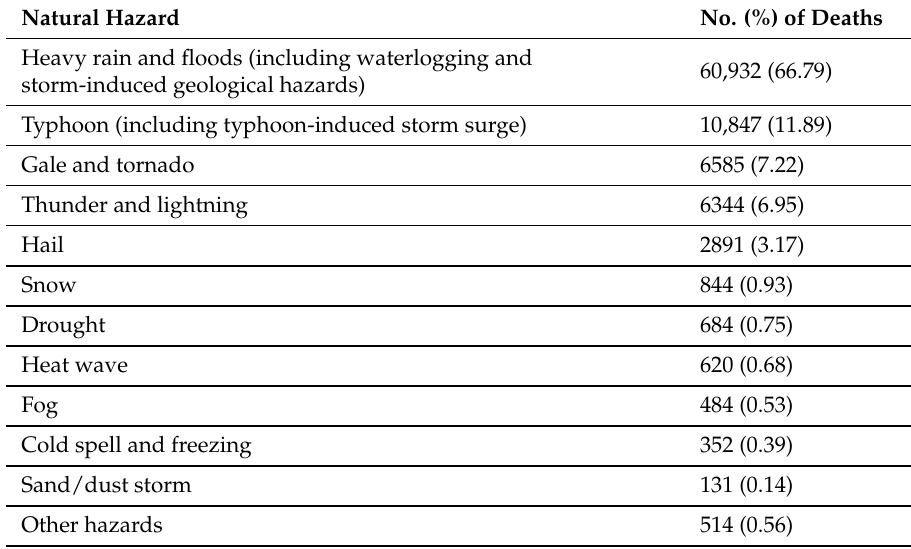
Table 1. Loss of human lives caused by meteorological hazards in China, 1983–2012. Natural Hazard Heavy rain and floods (including waterlogging